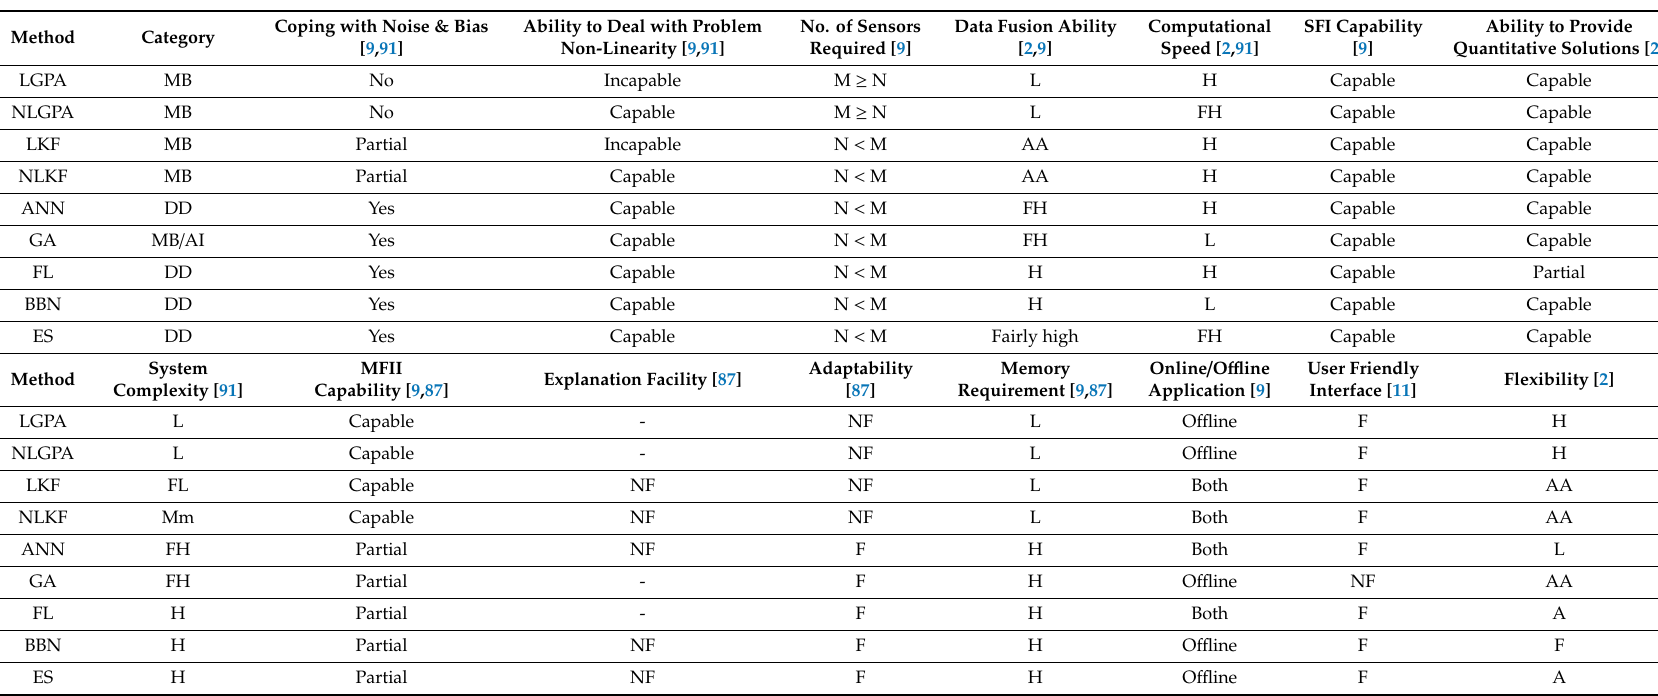
Table 6. Comparative summary of the major diagnostic methods concerning their capability towards the desirable